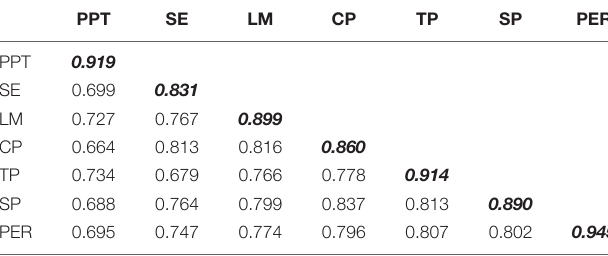
TABLE 2 | Outer model estimation.